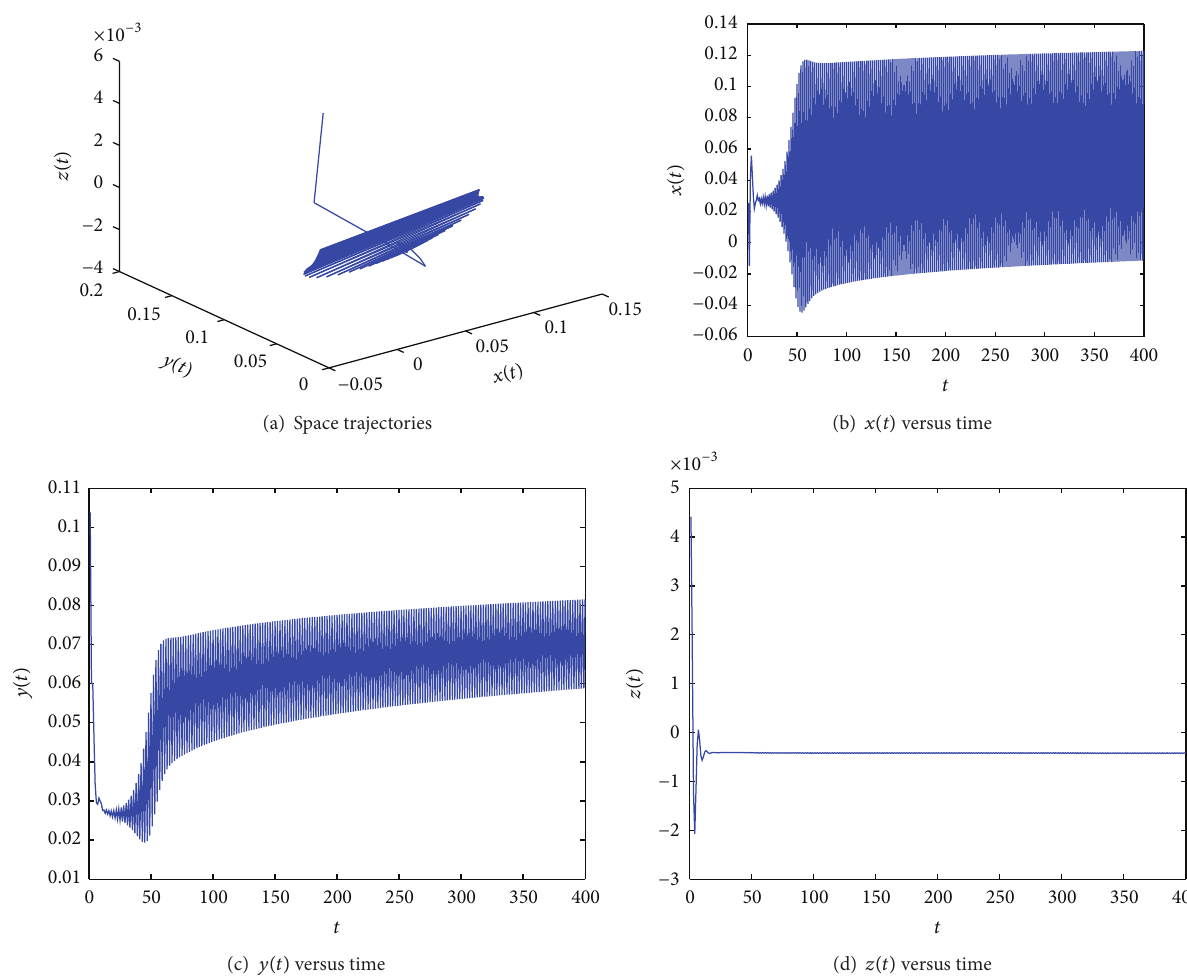
Figure 4: Space trajectory and the time responses of the estimated system about